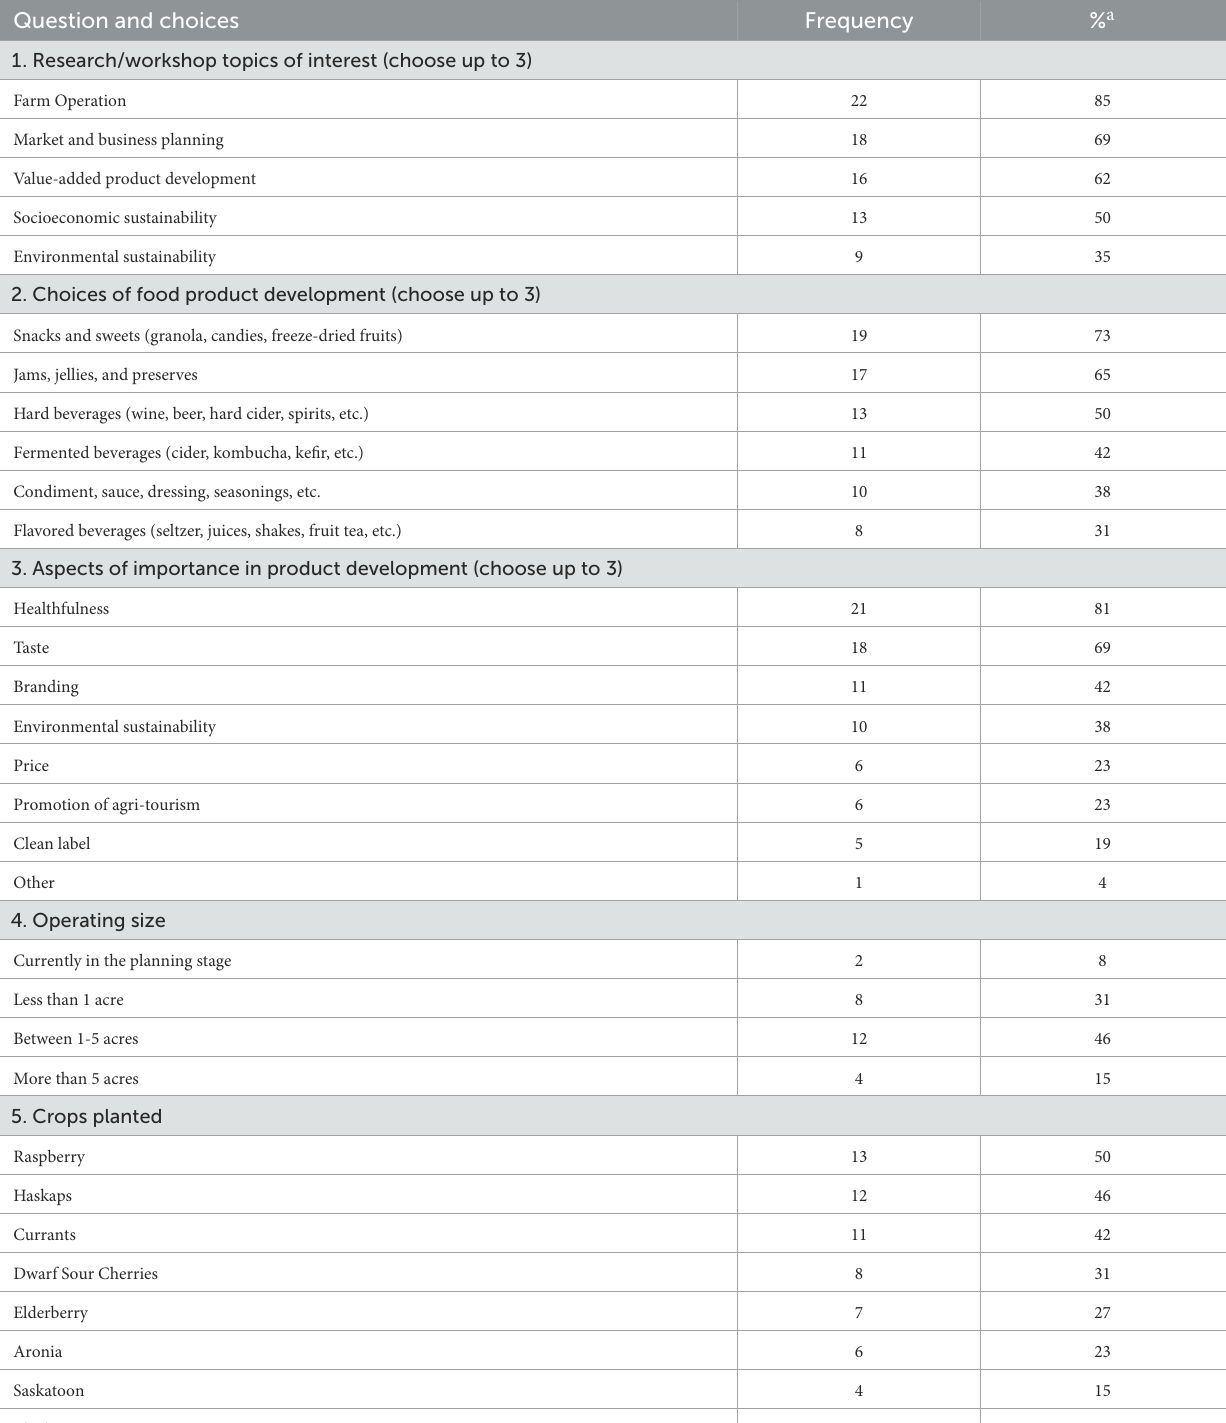
TABLE 1 Quantitative results from the survey with specialty fruit growers in Montana and Utah. Question and choices Frequency %